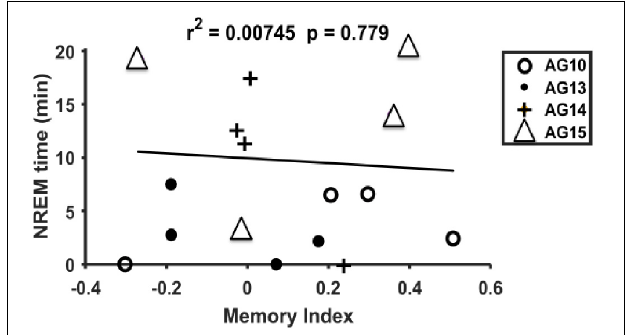
FIGURE 3 | Linear regression between the time spent at NREM and the memory index. NREM time (min during 3 h of resting) vs. memory index for all day and animals ( n = 4). No linear relationship was observed ( r 2 = 0.00745, p = 0.779).